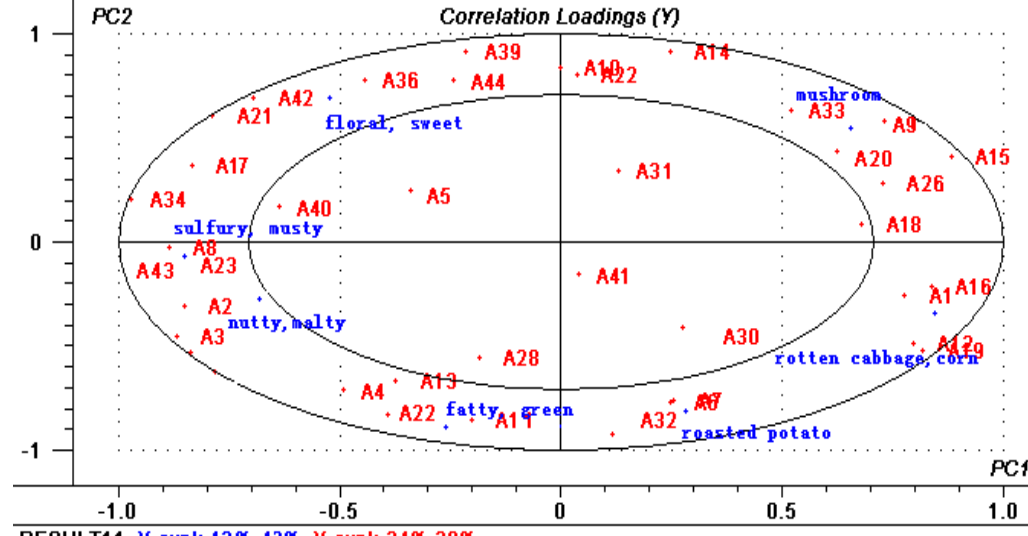
Figure 2. The model of PLS2 was derived from GC-O characterized compounds as the X-matrix and flavor notes as Y-matrix, respectively. Volatile compounds of A1 – A44 correspond to the code compounds in Table 1.